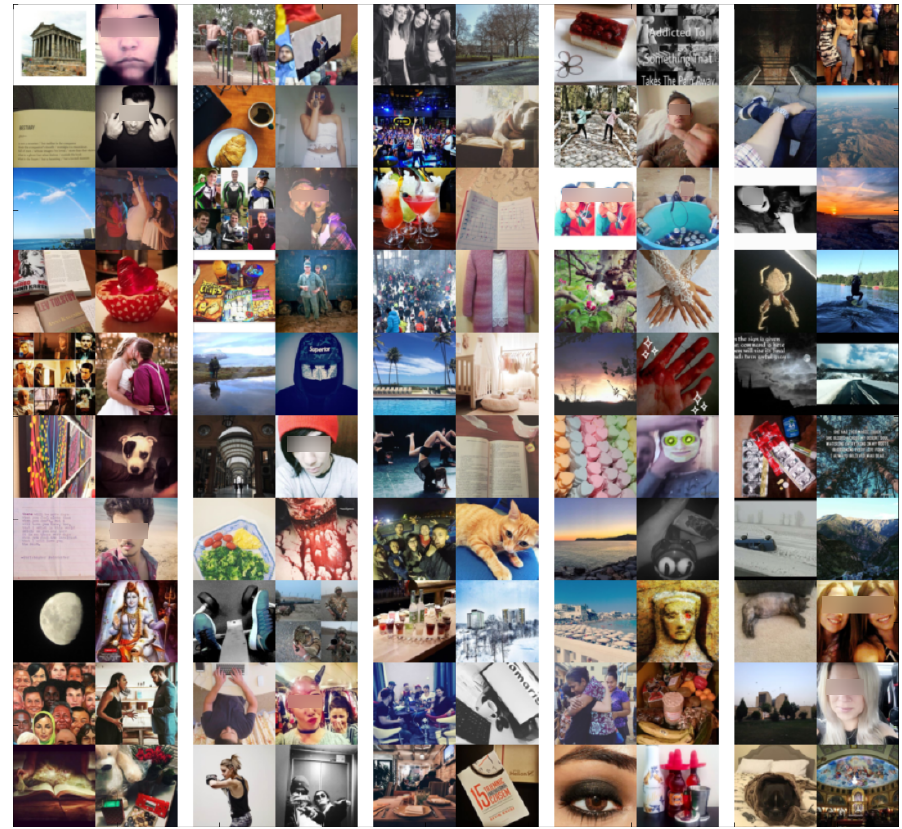
Figure 1. Image samples. Each column contains 10 images selected by matching their hashtags with the list of words listed in Table 1. From left to right: High openness, Low openness; High conscientiousness, Low conscientiousness; High extraversion, Low extraversion; High agreeableness, Low agreeableness ; High neuroticism, Low